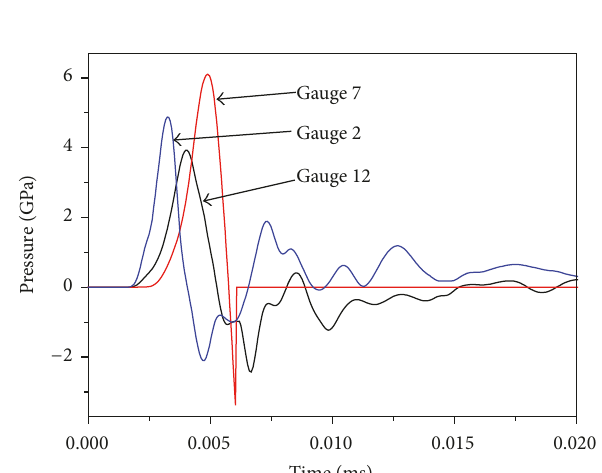
Figure 12: Tensile stress isograms.